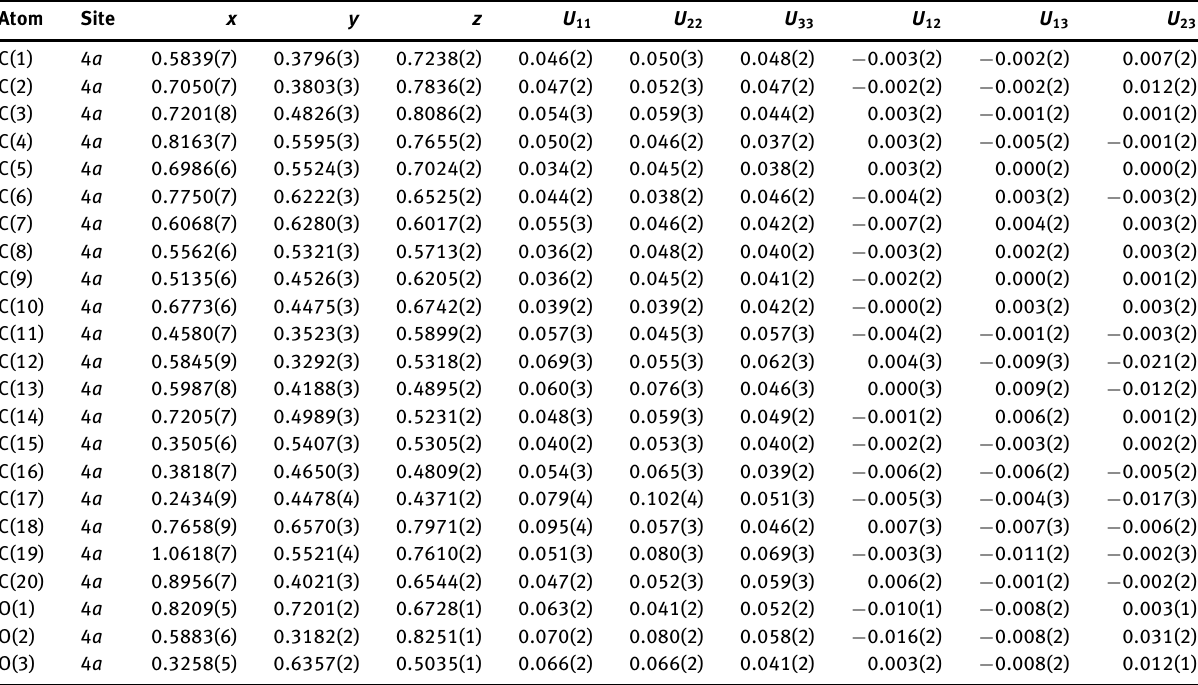
Table 3: Fractional coordinates and atomic displacement parameters (Å 2